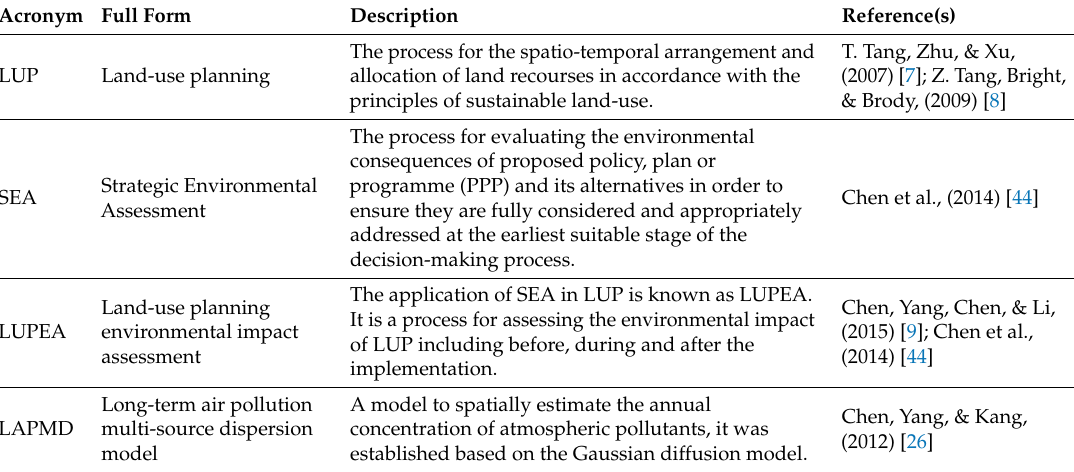
Table A1. Full forms and description of the